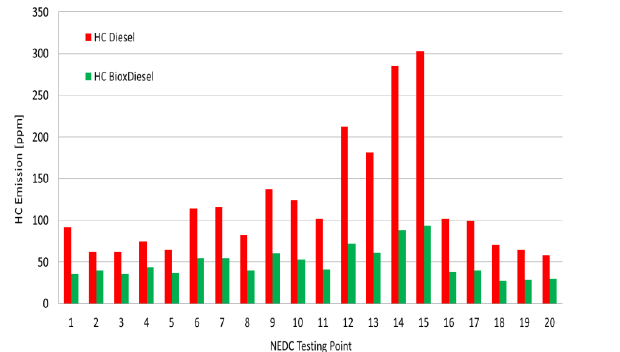
Fig. 7. Emission of unburnt hydrocarbons (HC) from the engine fed with Bioxdiesel and Diesel fuels